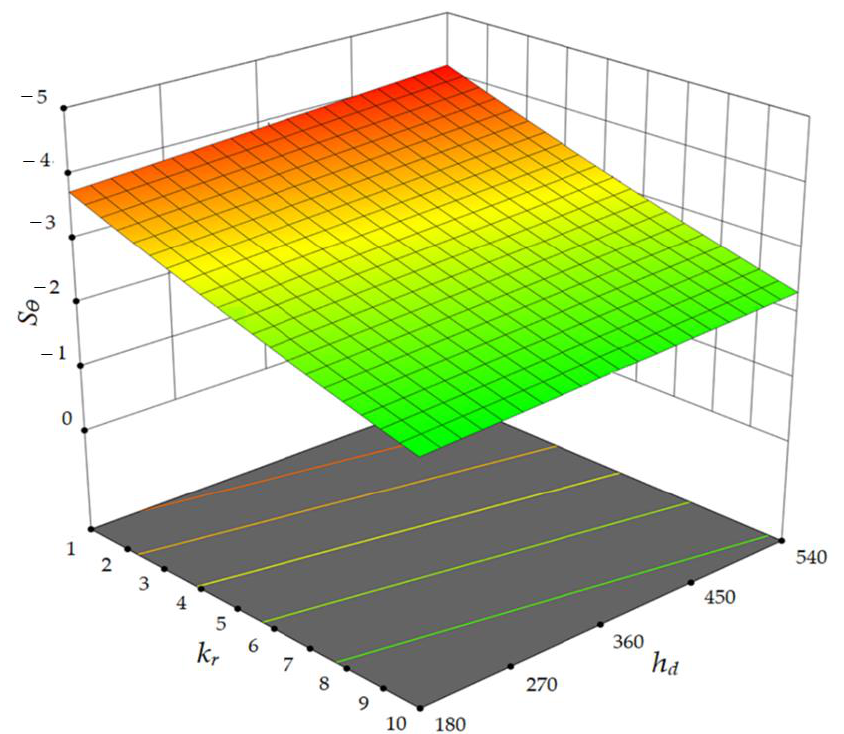
Figure 10. Effect of interaction between the dimensionless parameters h d and k r on skin factor with constant value for the third dimensionless parameter ( θ d = 1 ).